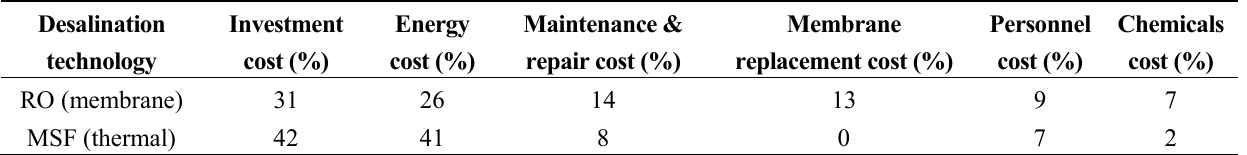
Table 3. Cost percentage in conventional RO and multi-stage flash distillation (MSF) of the same capacity in Lybia. Adapted from